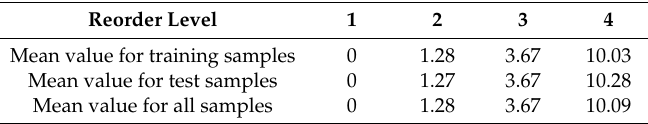
Table 7. Mean reorder frequency for different reorder levels.